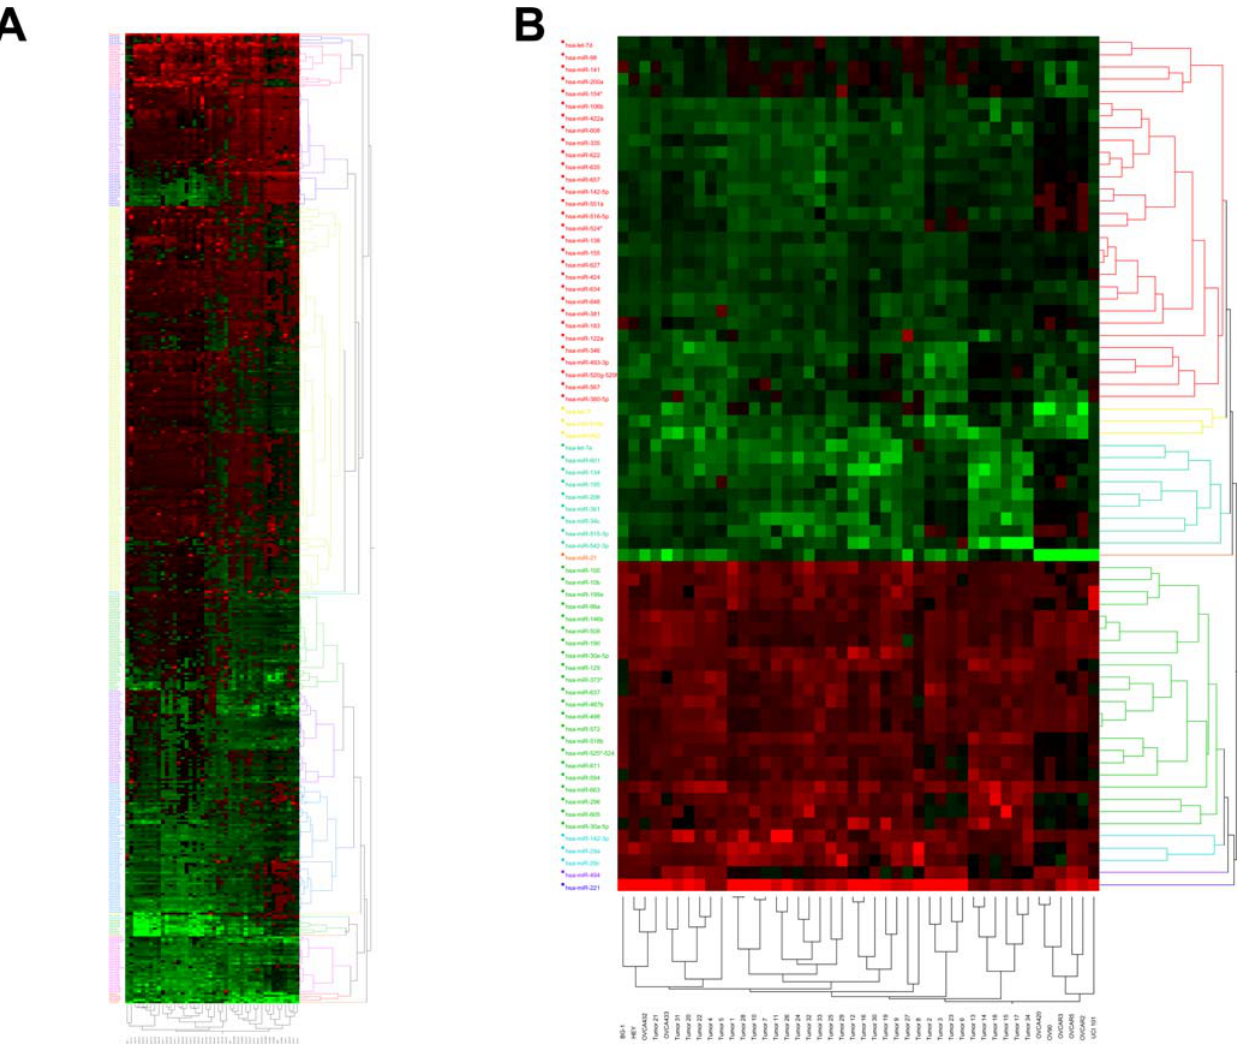
Figure 1. Cluster analysis of miRNA expression. Tree generated by cluster analysis of ovarian cancer tissues and cell lines based on (A) all tested miRNAs in tissues and cell lines, and (B) differentially regulated miRNAs (Fold change . 2.0 or , 0.5 in greater than 60% of the samples) in tissues and cell lines compared to the normal control HOSE-B cells.